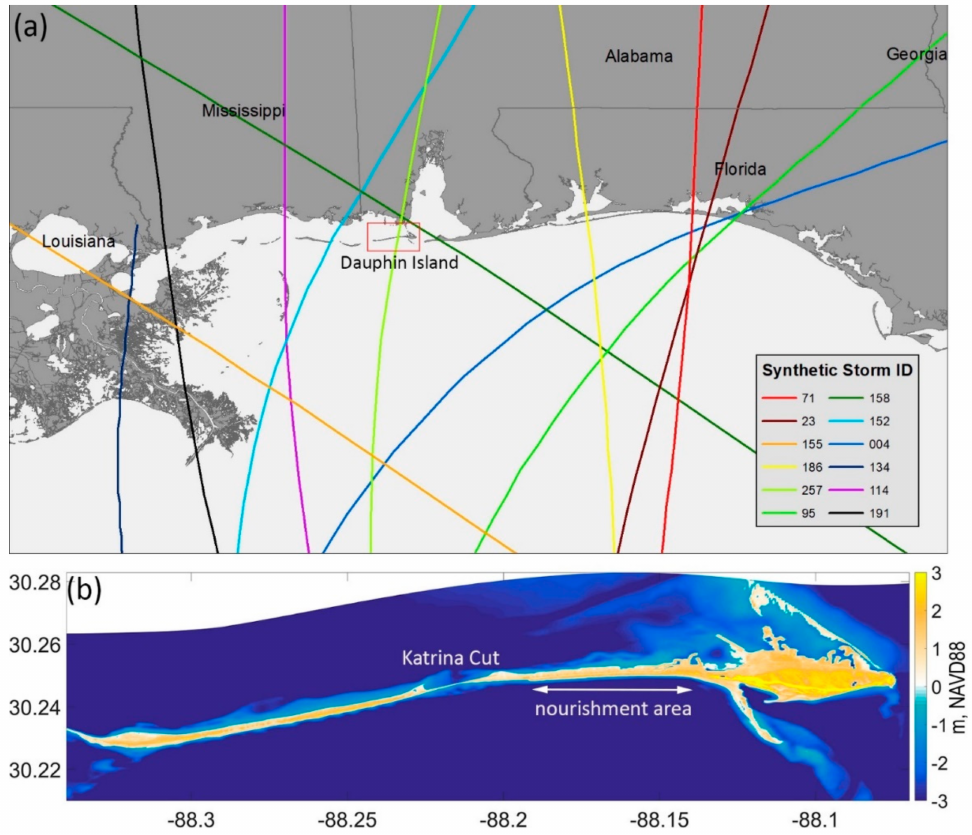
Figure 1. ( a ) Study area with synthetic storm tracks for a 30-year realization and ( b ) initial (Year 0) XBeach model bed level elevations (in meters, relative to NAVD88) at Dauphin Island. Base map layer in ( a ) provided by